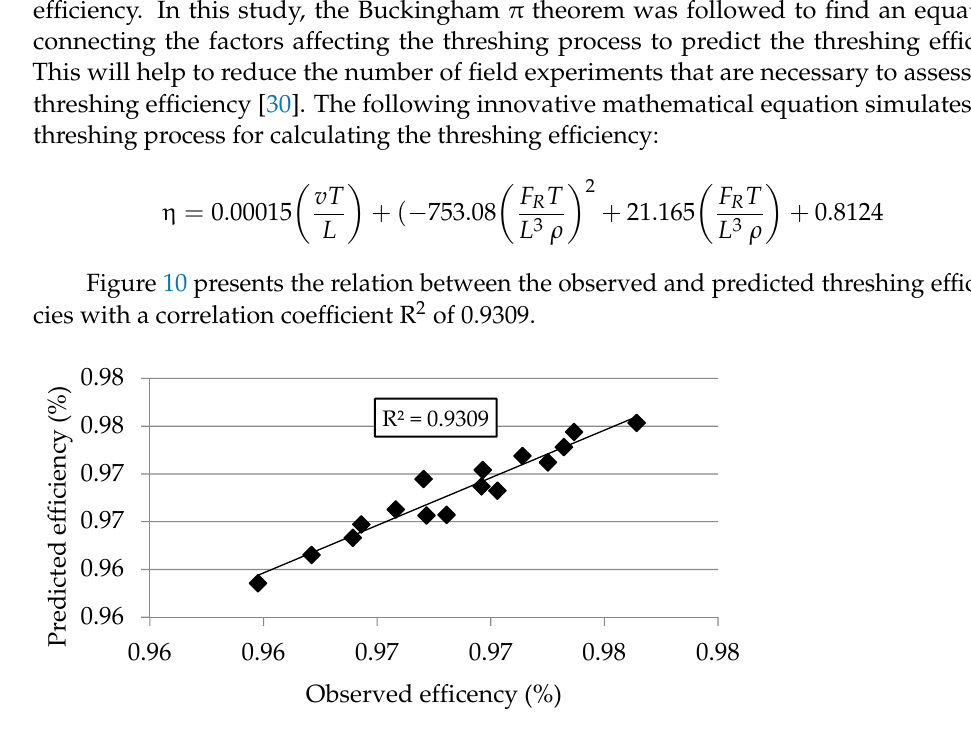
Figure 10. The relationship between the observed and predicted threshing efficiencies (%).